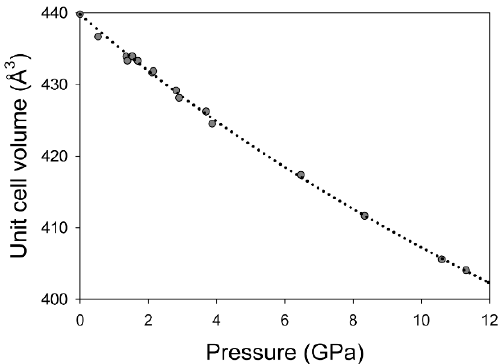
Figure 9. Pressure-volume data measured for bastnäsite-(La) fit to the 3rd order Birch–Murnaghan equation of state [41]. V 0 = 439.82 Å 3 , K 0 = 105 GPa, K’ = 5.58. Gray circles are measured volumes from Table 4, and dotted line represents equation of state fit to data.